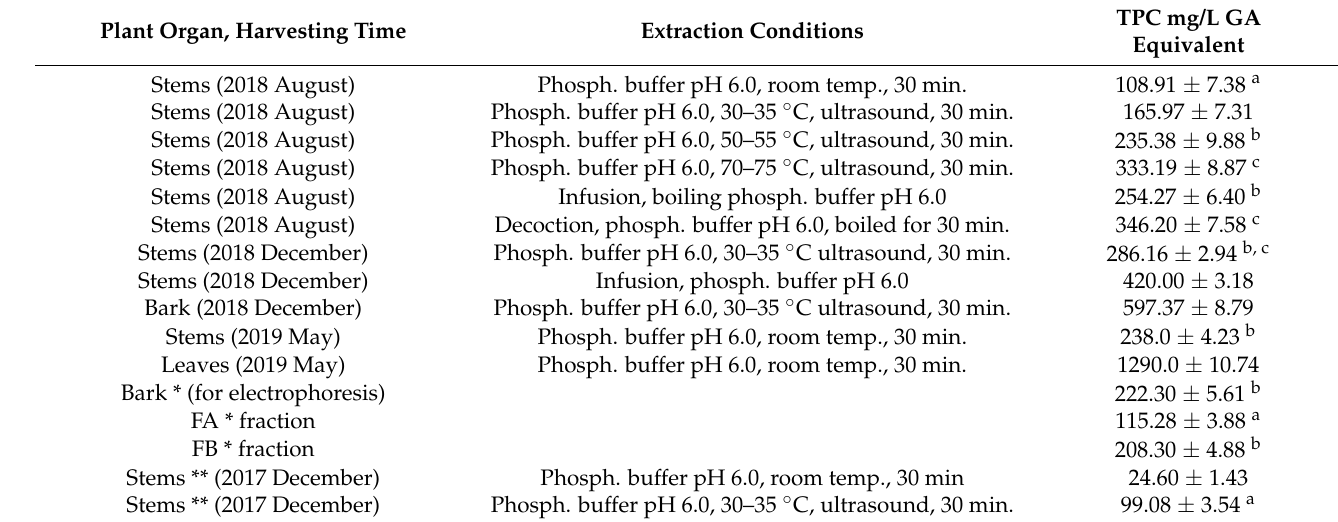
Table 1. Total polyphenolic compound content in various R. idaeus extracts.